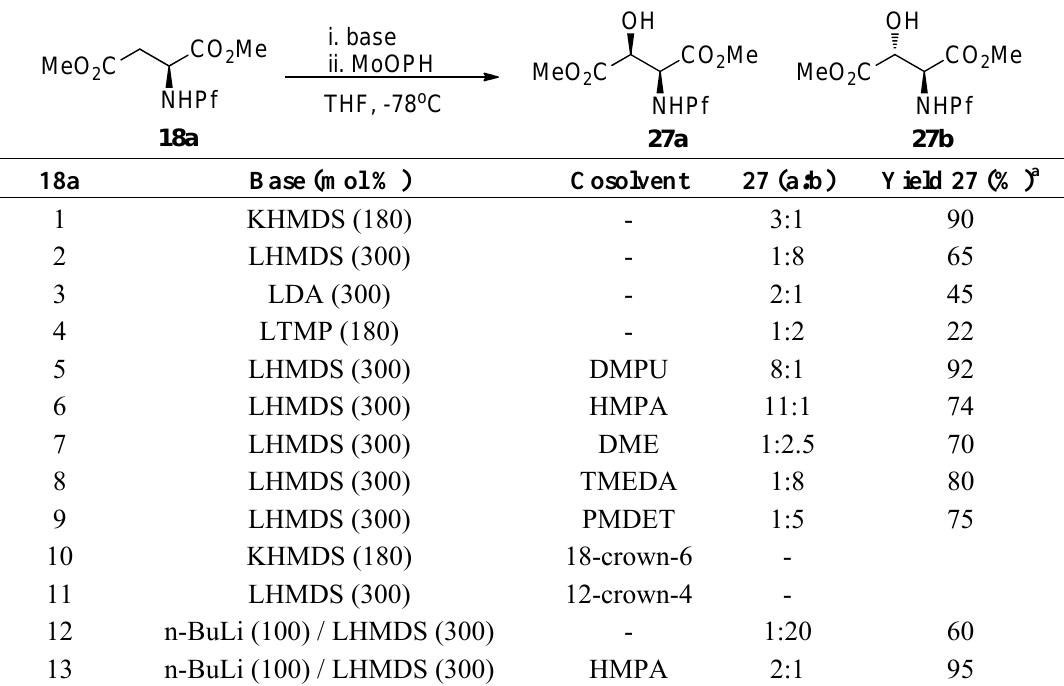
Table 3. Hydroxylation of L -aspartate methyl